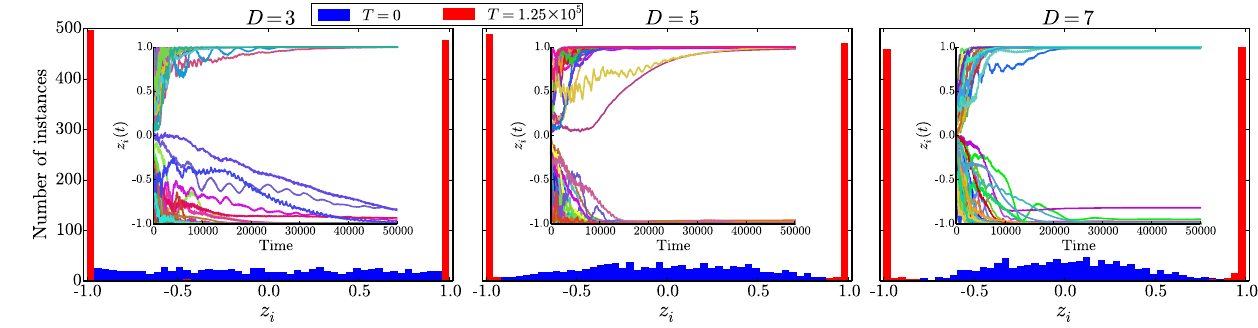
FIG. 7. N ¼ 1000 agents were simulated with a coupling strength of K ¼ − 2 . Histograms of z (in blue, corresponding to the initial condition having σ the distributions concentrate at 1 and − 1 for large T . In the insets, we show plots of z